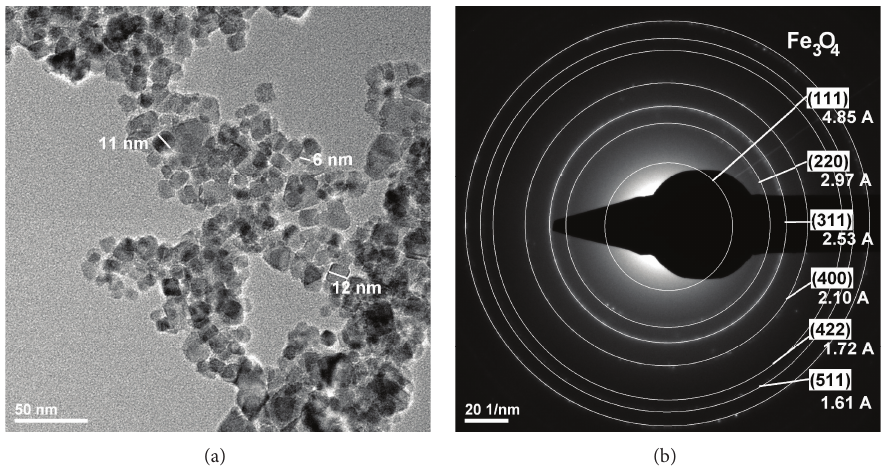
Figure 4: TEM and SAED images of pure magnetite nanoparticles.